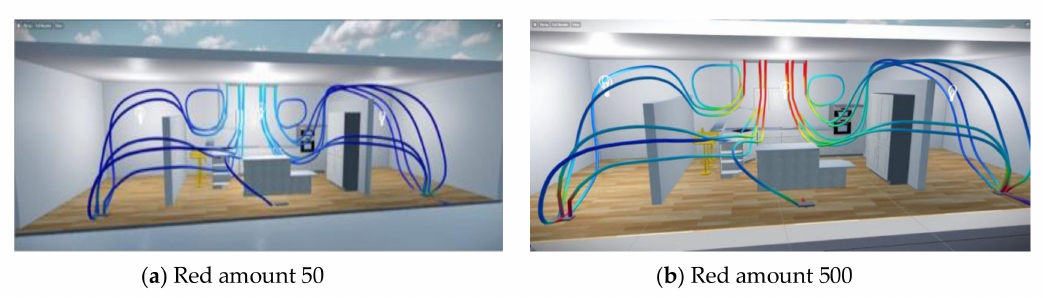
Figure 15. Airflows without animation in Stingray with red amounts of ( a ) 50 vs. ( b ) 500. ( a ) Airflows without animation in Stingray with red amounts of 50; ( b ) Airflows without animation in Stingray with red amounts of 500.